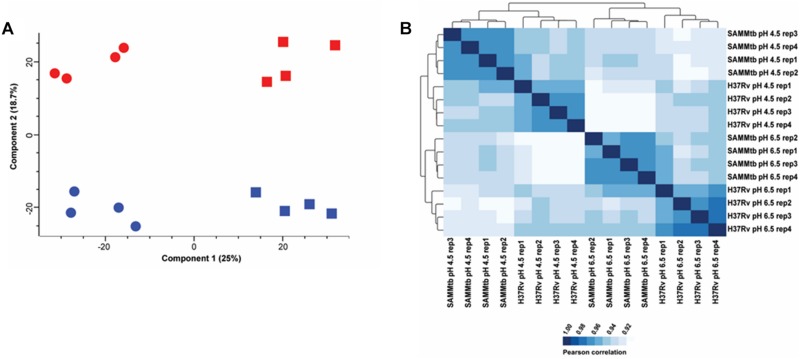
Quality control analysis of proteomics data reveals distinct clustering of M. tuberculosis H37Rv and M. tuberculosisΔleuDΔpanCD protein intensities. (A) Principle component analysis of z-scored MaxQuant LFQ intensities obtained from M. tuberculosis H37Rv (blue) and M. tuberculosisΔleuDΔpanCD (red) during control (pH 6.5; square) and acid stress conditions (pH 4.5; circle). (B) Correlogram of Pearson correlation coefficients from MaxQuant LFQ intensities obtained for M. tuberculosis H37Rv and M. tuberculosisΔleuDΔpanCD (SAMMtb) cultured at pH 6.5 and pH 4.5.